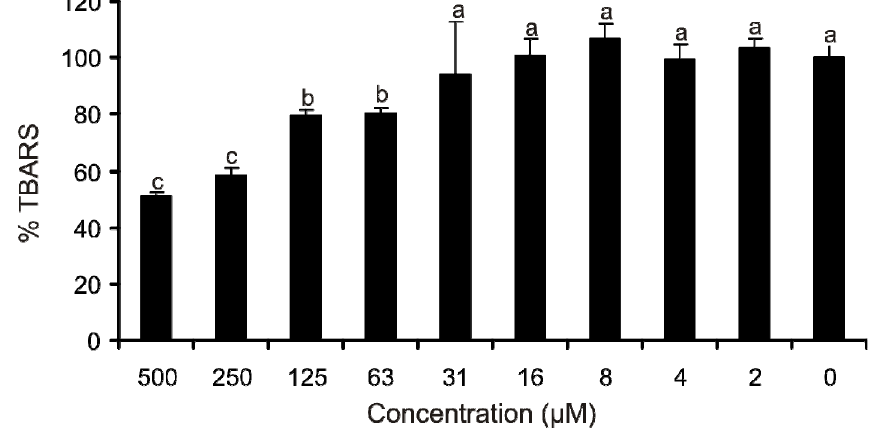
Figure 3. Reactive oxygen species (ROS) generation caused by QUIN in the Fe(II) autoxidation assay. ROS were detected by oxidative degradation of 2-deoxy- D -ribose and measured as thiobarbituric acid reactive species (TBARS), (100% = TBARS of the control reaction mixture without QUIN). Error bars indicate the standard deviation of three replicates; letters (a, b and c) indicate different levels of significance (95% Duncan); for details, see the Experimental